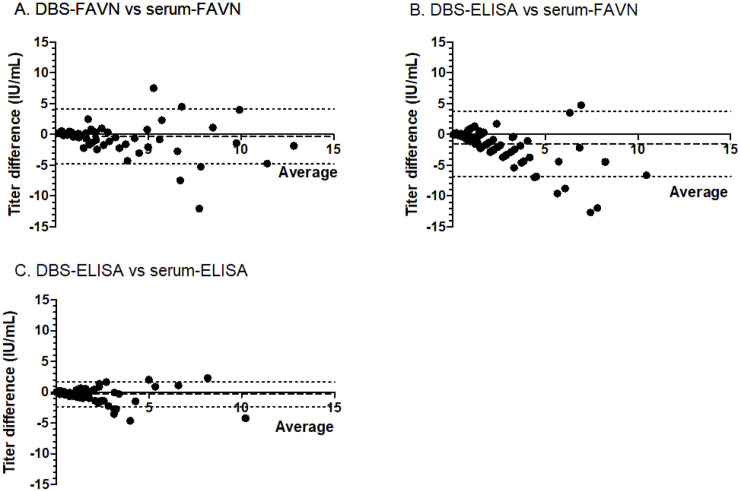
Bland-Altman plots of the mean titer of DBS and serum plotted against the difference between both values.Panel A shows the average antibody titer (IU/ml) of the DBS and sera measured with the FAVNt on the x-axis and the value (IU/ml) of the DBS minus the value of the serum on the y-axis. Panel B shows the average value of the DBS-ELISA and the serum-FAVNt on the x-axis and the value of the DBS-ELISA minus the value of the serum-FAVNt on the y-axis. Panel C shows the mean antibody level of the DBS and sera measured with the Platelia-II-ELISA on the x-axis and the value of the DBS minus the value of the serum on the y-axis. The long-dashed lines close to y = 0 represent the mean bias, the short-dashed lines represent the 95% limits of agreement (mean bias ±1.96 times the SD).